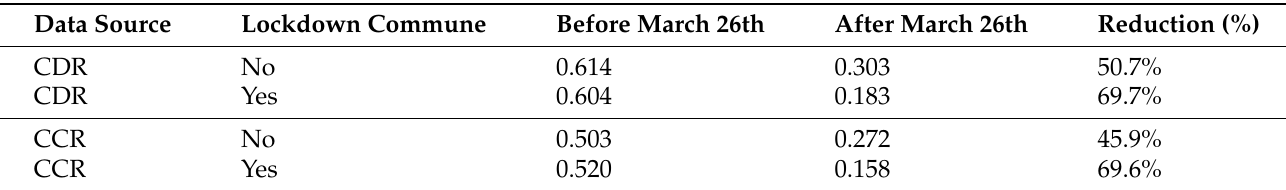
Table 2. The overall effect of lockdown policies in Santiago, Chile, measured from mobile phone connectivity (CDR) and credit card transactions